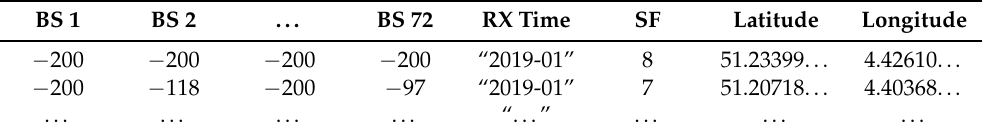
Table 1. Structure of the urban LoRaWAN dataset. Each row is a LoRaWAN message showing the receiving base station (BS) with RSSI value, message reception time (RX time), LoRa spreading factor, latitude and longitude at time of transmission.